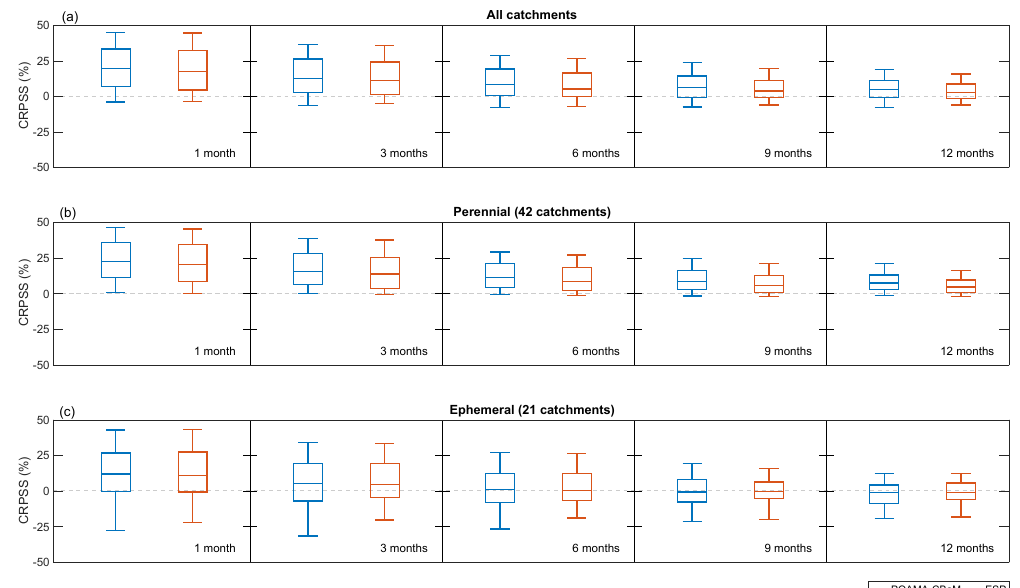
Figure 7. Skill (CRPSS) for 63 catchments by the forecast accumulation period for FoGSS forecasts forced by forecast (POAMA-CBaM) and historical (ESP) rainfall. For each lead time, forecast skill is summarized for all months and catchments with box and whisker plots. Boxes show the interquartile range with the median; whiskers give the 10th and 90th percentiles. (a) shows all catchments, (b) shows perennial catchments, and (c) shows ephemeral catchments.